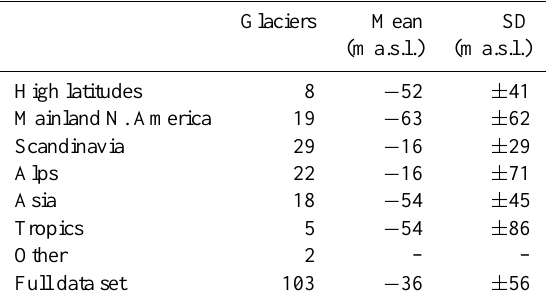
Table 3. Mean and standard deviations of Kurowski error E mean for glaciers in various regions. Glaciers Mean SD (ma.s.l.) (ma.s.l.)